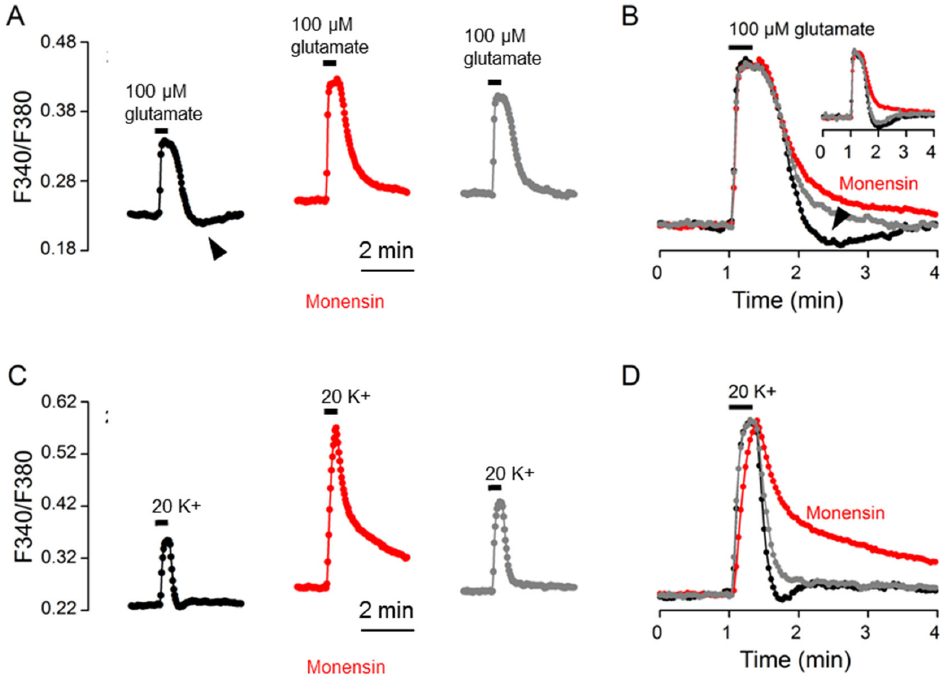
Figure 6. Monensin effects on the Ca 2+ response to 100 µ M glutamate ( A , B ) and 20 mM K + ( C , D ) from the same cells. ( A , C ) A representative experiment (an average of 13 cells) showing the effects of 10 µ M monensin on the Ca 2+ responses to 100 µ M glutamate ( A ) and 20 mM K + ( C ). ( B , D ) Superimposition of the Ca 2+ responses in the control (black traces), in 10 µ M monensin (red traces), and after washout (grey traces) elicited by 100 µ M glutamate ( B ) and by 20 mM K + ( D ). Monensin markedly slowed the clearance of Ca 2+ for the 20 K + -evoked Ca 2+ response ( B ), but had only a minimal effect on that of glutamate-evoked Ca 2+ response ( D ). Note that monensin eliminated the rebound Ca 2+ suppression (marked by arrowheads) ( A , B ). The inset shows another experiment to indicate the reversible elimination of rebound Ca 2+ suppression by monensin ( B ). Similar results were also obtained from 5 other experiments.